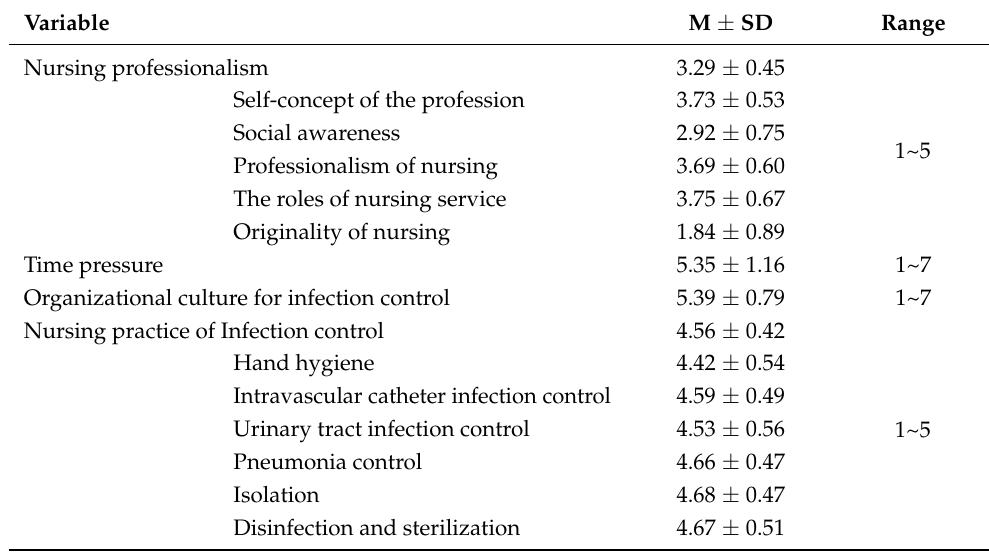
Table 2. Mean score for Study Variables ( N = 183).